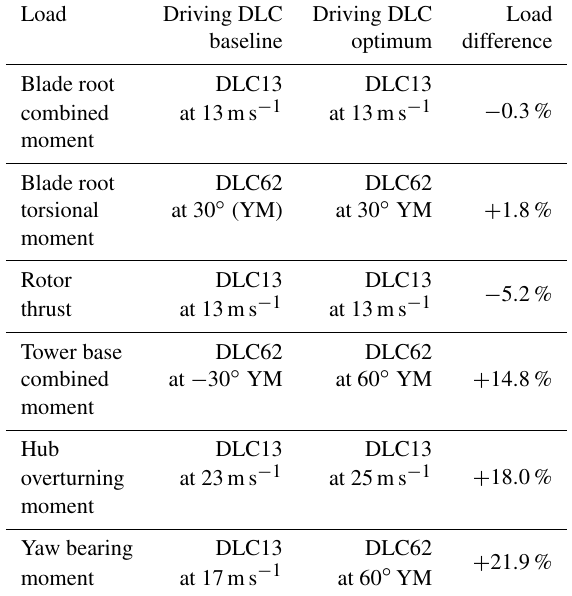
Table 11. Summary of load analysis for the LIR design of